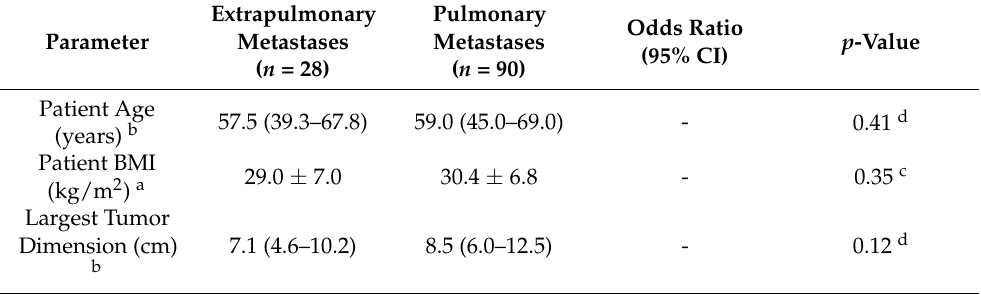
Table 3. Distribution of the metastatic soft tissue sarcoma patients’ clinical and tumor